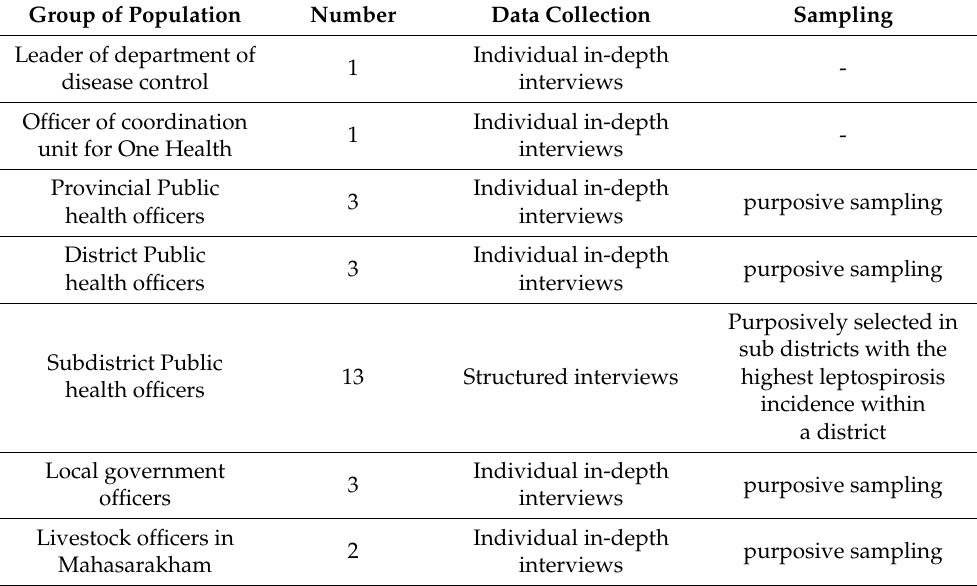
Table 1. Presentation of study